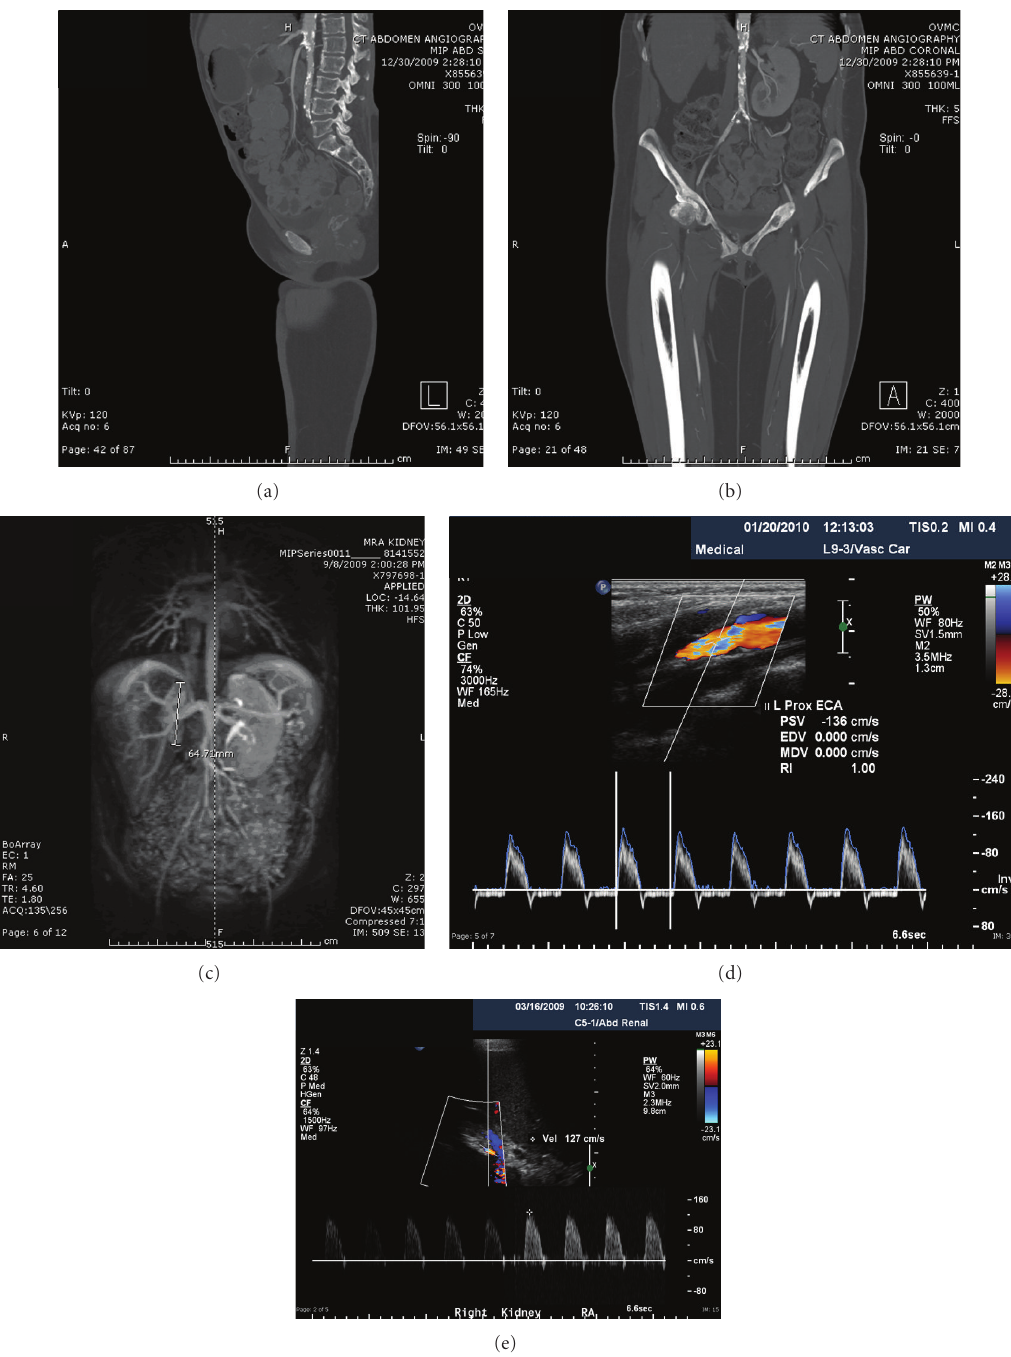
Figure 1: Images of patient J.S. and Takayasu’s arteritis (a) Patient J.S. CT angiogram of abdomen and pelvis from 12/31/2009. Sagittal reconstruction showing severe calcifications along the abdominal aorta. (b) Patient J.S. CT angiogram of abdomen and pelvis from 12/31/2009. Coronal reconstructions showing severe abdominal aortic vessel calcification. (c) Patient J.S. MRA of abdomen and pelvis from 09/08/2009. 3D angiogram showing severe abdominal aortic calcifications along length of abdominal aorta, a small right kidney, moderate grade SMA stenosis, low signal in the right renal artery concerning for right renal artery stenosis or right renal artery occlusion, and narrowing of the bilateral iliac and femoral arteries (d) Patient J.S. Doppler flow of left external carotid artery from 01/20/2010. It shows a 50-69% stenosis, as well as notable intimal thickening all along the bilateral carotid arteries, including the left common carotid artery. (e) Renal ultrasound with Doppler from 03/16/2009. It shows an abnormally small right kidney measuring 6.1 cm, right renal artery with high resistance waveform and no diastolic flow suspicious for renal-artery occlusion versus